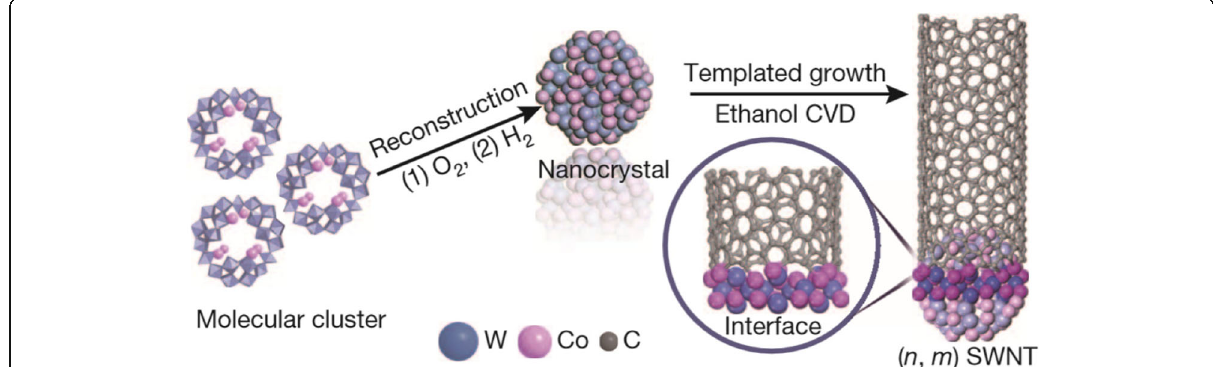
Fig. 11 Growth of high purity, single chirality (12,6) SWCNTs using tungsten-based bimetallic solid alloy catalyst (W 6 Co 7 ). These alloy nanoparticles catalyze the CNT growth on SiO 2 /Si substrates via ethanol CVD that help in chirality control during CNT growth. Adapted from [124]